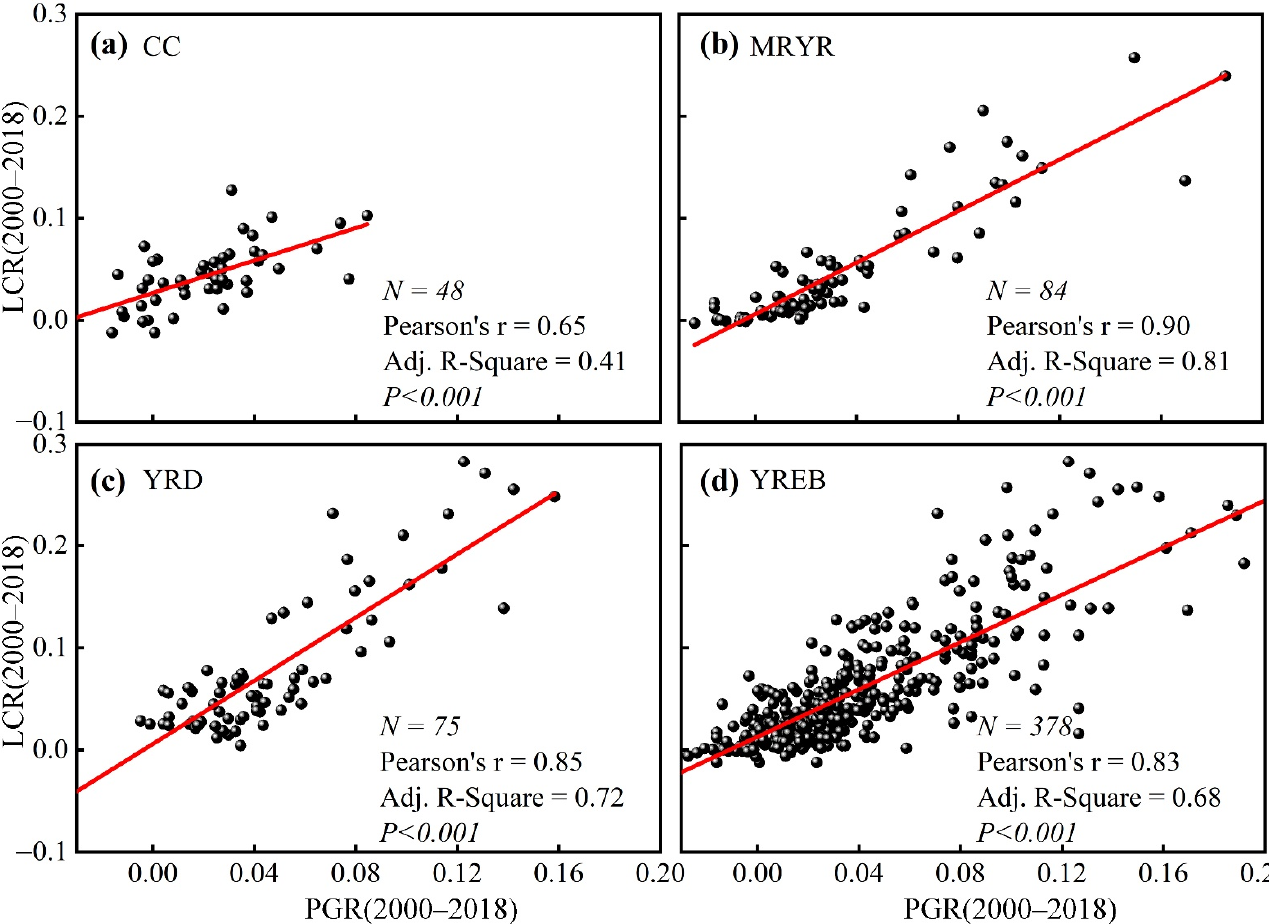
Figure 6. Scatterplots describing the relationships between LCR and PGR across ( a ) CC, ( b ) the MRYR, ( c ) the YRD, and ( d ) the YREB during 2000–2018. Each point represents a prefecture-level city.